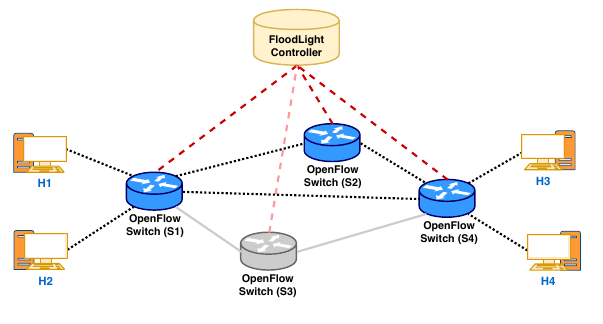
Figure 3. Reactive Load Balancing